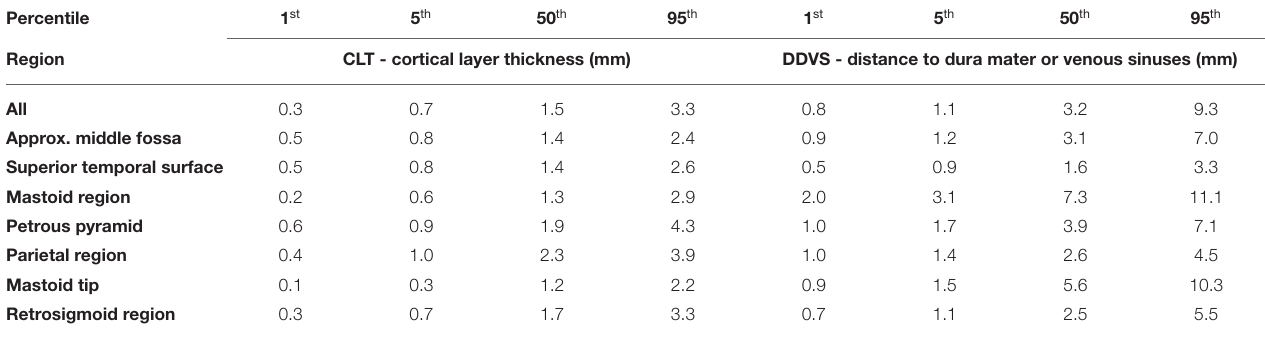
TABLE 1 | Select percentiles of both cortical layer thickness, and distance to dura mater or venous